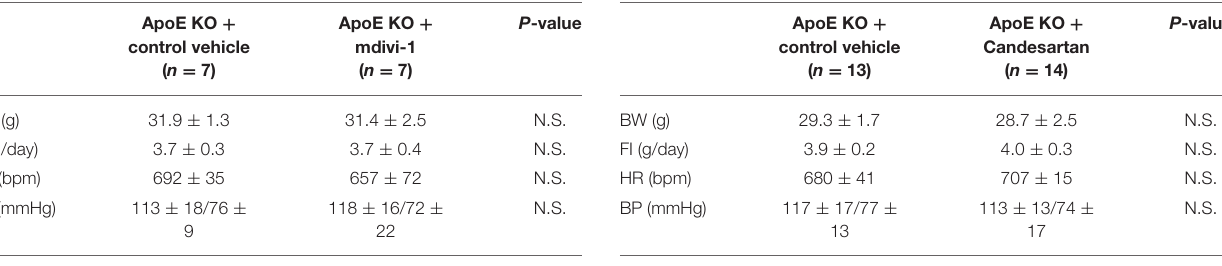
TABLE 2 | Body weight, food intake, heart rate, and blood pressure of ApoE KO mice administered with mdivi-1 or the control vehicle.